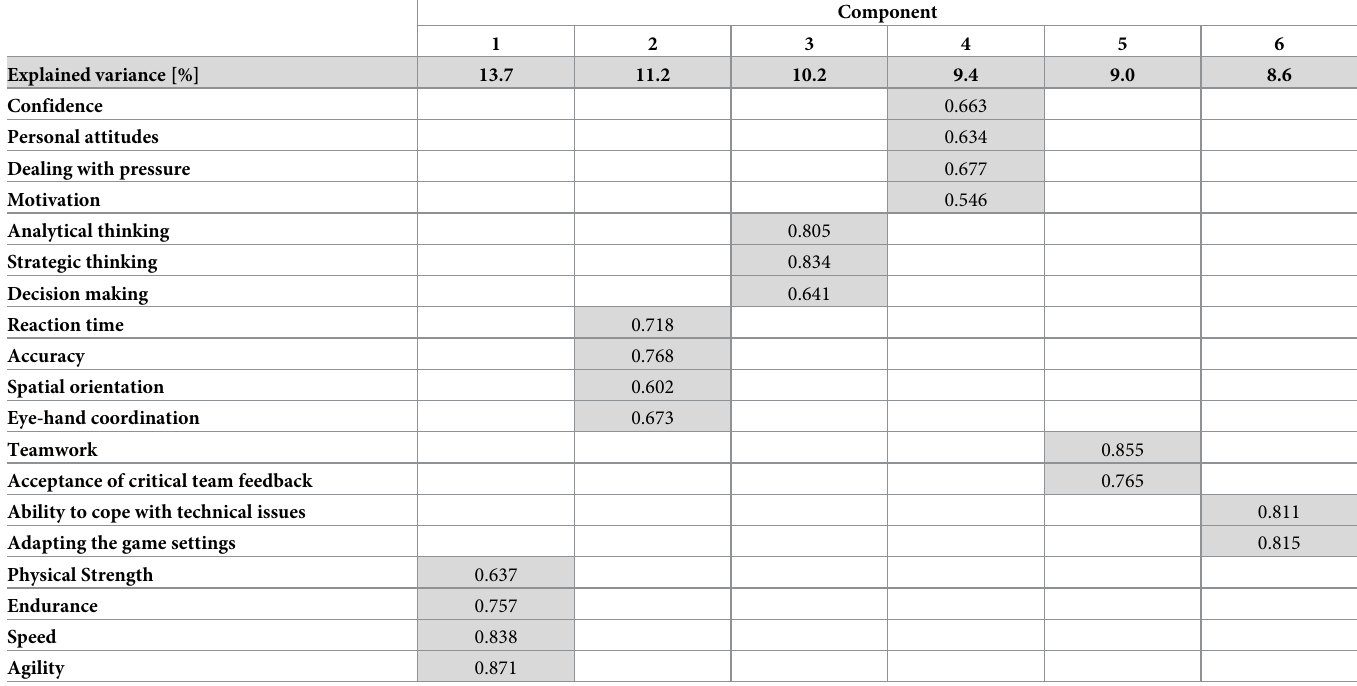
Table 23. Factor analysis–competence structure (only factor loadings > 0.5 are